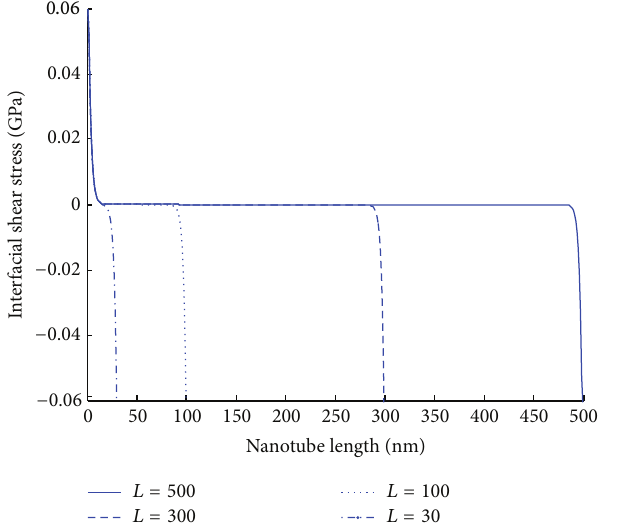
Figure 7: Shear stress distribution at SWNT/alumina interface along the tube length ( 𝑑 = 3 nm, 𝑡 = 0.34 nm).